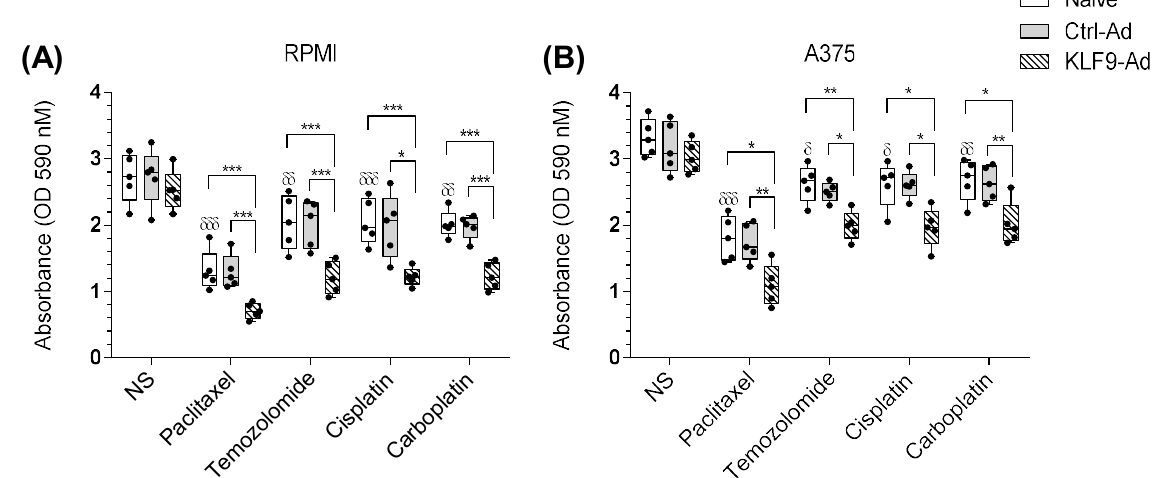
Figure 6. KLF9 overexpression potentiated TMZ, CIS, or CARB effects on cell viability in malignant melanoma-derived cell lines. Naïve, control-adenovirus (ctrl-ad) or KLF9-adenovirus transduced (KLF9-ad) RPMI-7951 ( A ) and A375 cells ( B ) treated with paclitaxel, TMZ, CIS, or CARB, 100 nM for 24 h, showed differential effects on cell viability. Data ( n = 5), significant difference was determined using ANOVA with Tukey’s correction for multiple comparisons. * p ≤ 0.05, ** p ≤ 0.01, *** p ≤ 0.001 vs. non-stimulated cells, δ p ≤ 0.05, δδ p ≤ 0.01, δδδ p ≤ 0.001 vs. naïve non-stimulated